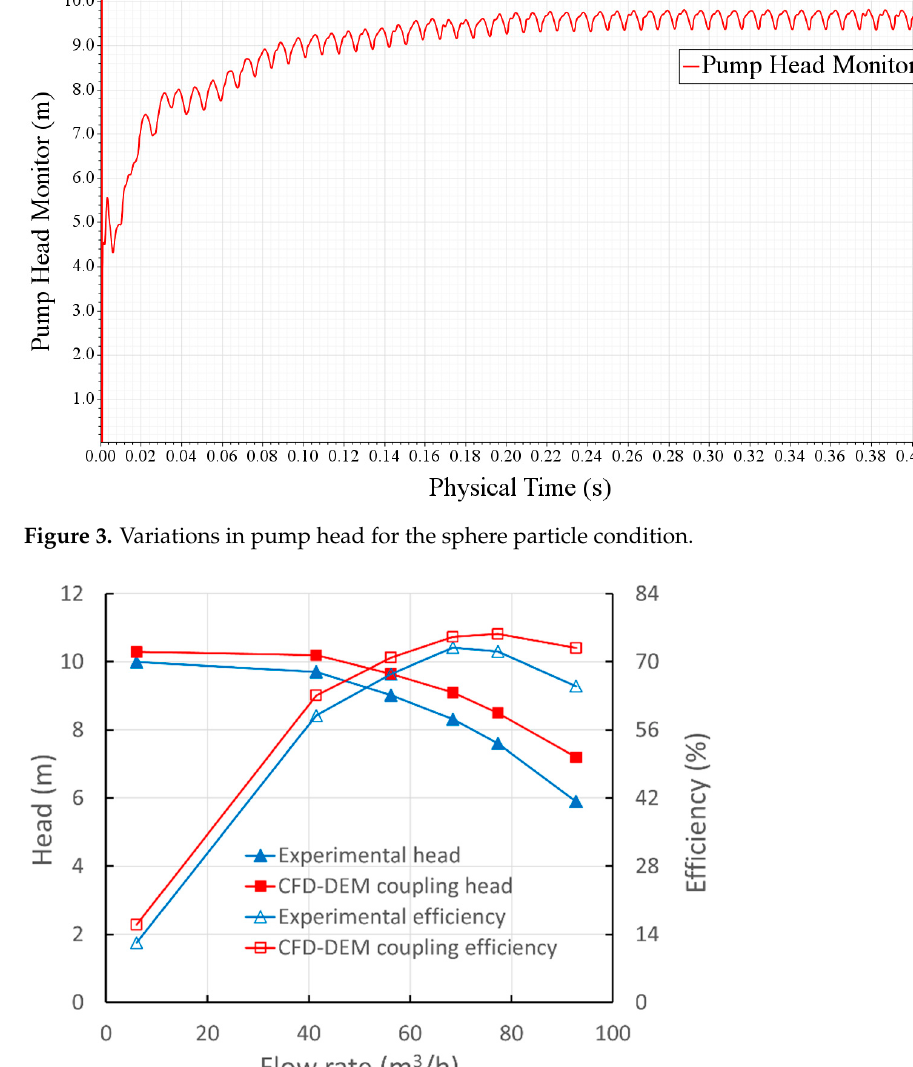
Figure 3. Variations in pump head for the sphere particle condition.